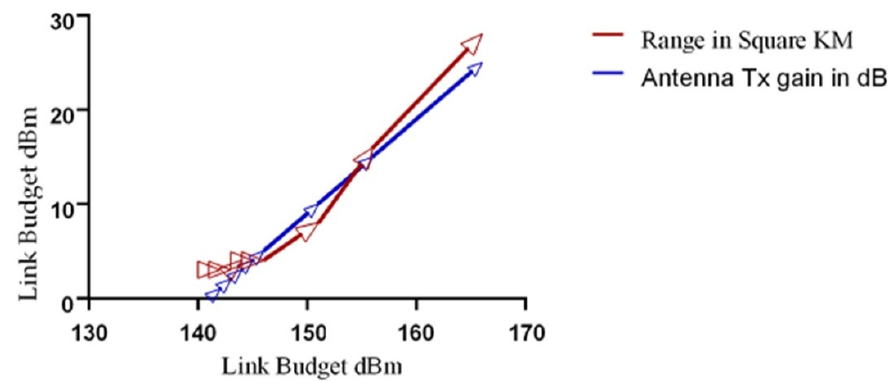
Figure 12. Link budget variation with range.